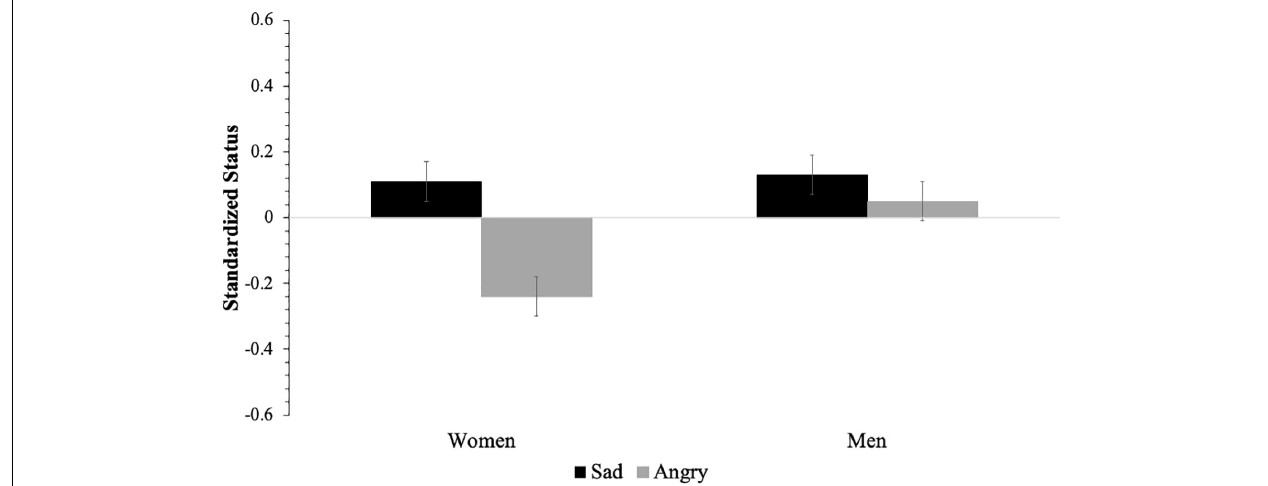
FIGURE 1 | Interaction between applicant gender and emotion. Error bars represent ± one standard error.